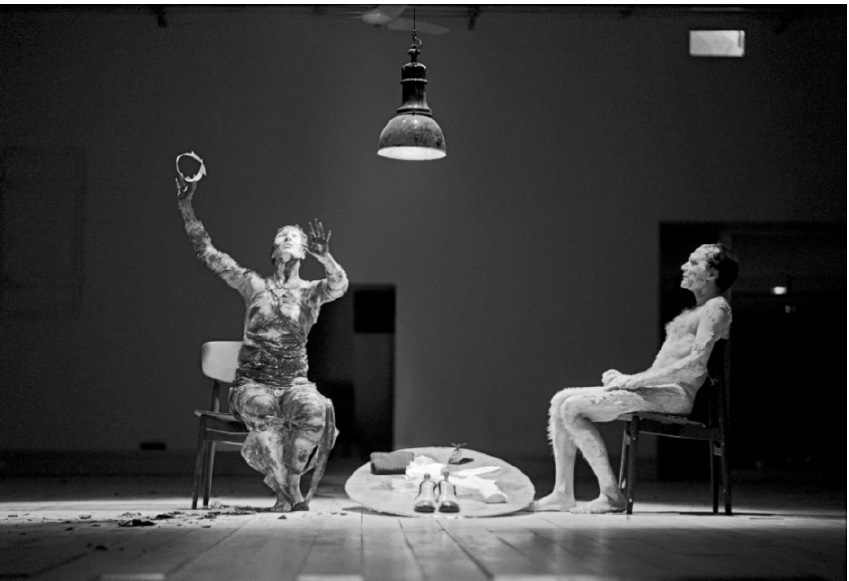
Figure 4. Agave in a bloody costume made of bandages, sitting with Cadmus, his body covered with plaster, in Die Bakchen directed by Klaus Michael Grüber for the Berlin Schaubühne, 1974. Deutsches Theatermuseum München, © Helga Kneidl.